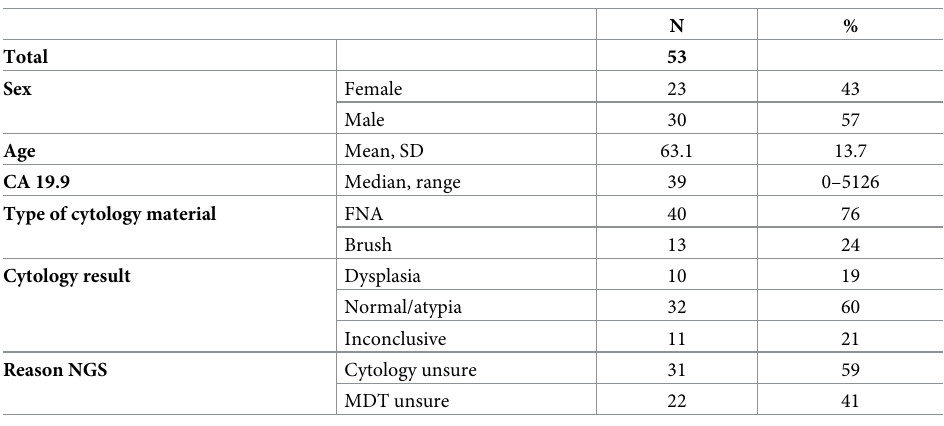
Table 1. Patient